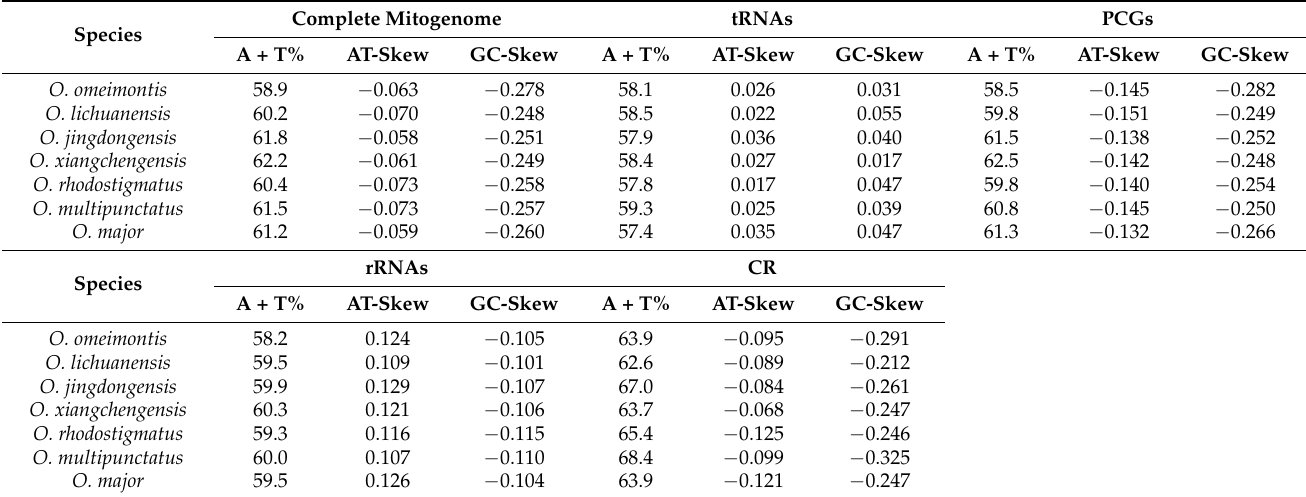
The relative synonymous codon usage (RSCU) values of the O. omeimontis mitogenome are shown in Figure 2 and Table S4. The results indicate that six codon families of UUU (177), UUA (172), CUU (153), CUA (141), AUU (198), and AUC (140) are most used in O. omeimontis , with more than 140 instances. In addition, six codon families (UUU, UUA, CUU, CUA, AUU, and AUC) are most used of all seven Oreolalax species, and the six least used codon families among the seven Oreolalax species were AAG, CGC, CGG, CGU, ACG, and UGG (Table S4). Obviously, overrepresentation of the Us (Ts) in frequently used codons indicates that the codon usage of PCGs contributed to both the A + T bias, and that Ts (Us) are the most abundant base of Oreolalax mitogenomes (Table 2). As for the codon RSCU values of seven Oreolalax species, O. omeimontis , O. xiangchengensis , O. multipunctatus, and O. major shared UCU (encoding serine) as their common codon with highest RSCU value, ranging from 2.17 ( O. major ) to 1.87 ( O. omeimontis ); while O. rhodostigmatus , O. jingdongensis, and O. lichuanensis had the highest RSCU value for CGA (encoding arginine) as their common codon with highest RSCU value, ranging from 2.17 ( O. major ) to 1.87 ( O. omeimontis ) (Table S4). Moreover, the coding codon with the lowest RSCU value of O. omeimontis was ACG (encoding threonine; with an RSCU value of 0.20), while that of O. xiangchengensis was CCG (proline; 0.14), O. multipunctatus was UCG (serine; 0.19), O. major was AAG (lysine; 0.10), O. lichuanensis was GCG (alanine; 0.20), whereas O. rhodostigmatus and O. jingdongensis had their lowest RSCU value for codon CGG (0.11 for O. rhodostigmatus and 0.16 for O. jingdongensis ), which encodes arginine (Table